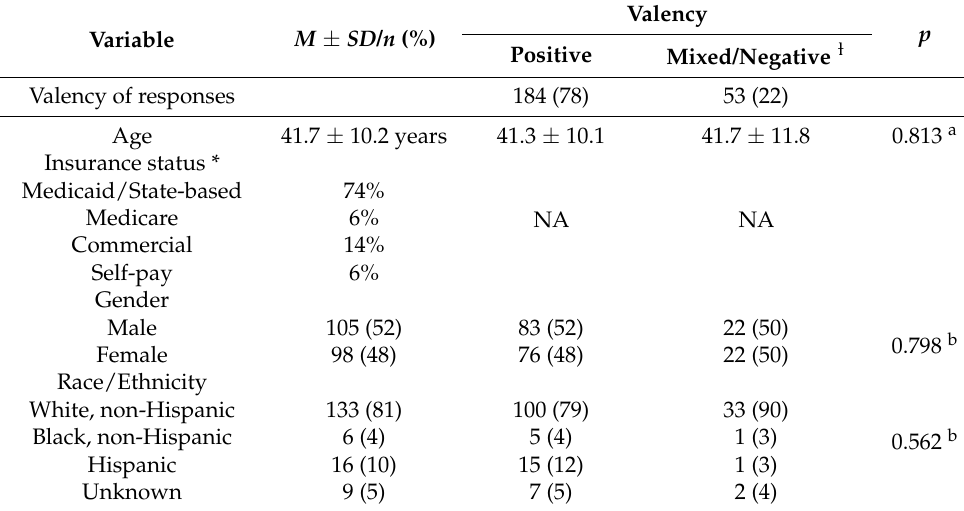
Table 2. Demographics and valency characteristics ( n = 237).